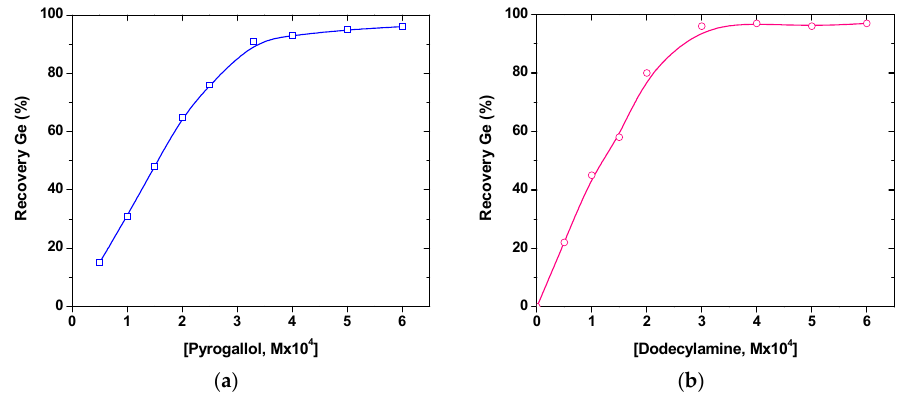
Figure 2. Ion flotation of germanium from dilute aqueous solutions (1 × 10 − 4 M initial concentration): ( a ) Effect of pyrogallol (activator) concentration on germanium ion recovery; dodecylamine concentration kept constant at 2.2 × 10 − 4 M; and ( b ) varying the concentration of the collector, with 3.3 × 10 − 4 M pyrogallol added; effect on recovery and certification of germanium flotation mechanism. Reprinted with permission; copyright Elsevier [38].